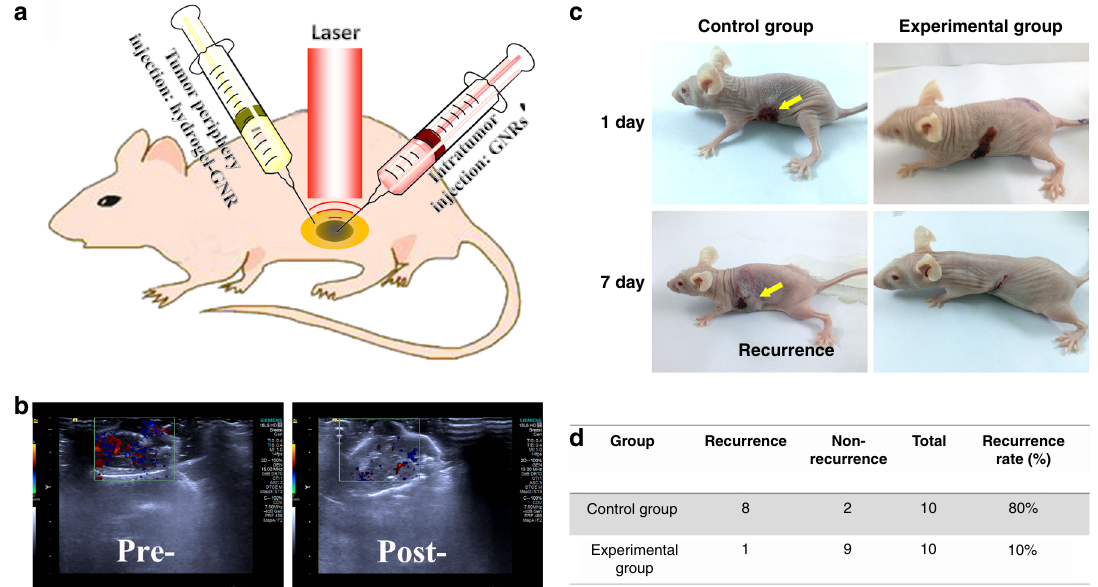
Fig. 9 Explorations on suppressed tumor recurrence using this starvation therapy. a Experiment schematic of tumor recurrence inhibition on PANC-1 tumor-bearing nude mice that received the special treatment wherein hydrogel – GNR was fi rst injected into the surrounding periphery of PANC-1 tumor and laser (1) irradiation was carried out for triggering gelation process, followed by GNRs injection into the PANC-1 tumor and laser (2) irradiation for ablating PANC-1 tumor. b CDFI images of PANC-1 tumor and its periphery before and after the special treatment in ( a ). c Digital photos of nude mice-bearing PANC-1 solid tumors that experiencing two different treatments, and one is only GNRs injection in tumor uniting laser (2) irradiation for tumor ablation (designated as control group), and another is the special treatment in a (designated as experimental group), wherein yellow arrows indicate the tumor recurrence after ablation. d Quantitative statistics of tumor recurrence of PANC-1 tumor implanted on nude mice ( n = 10) in